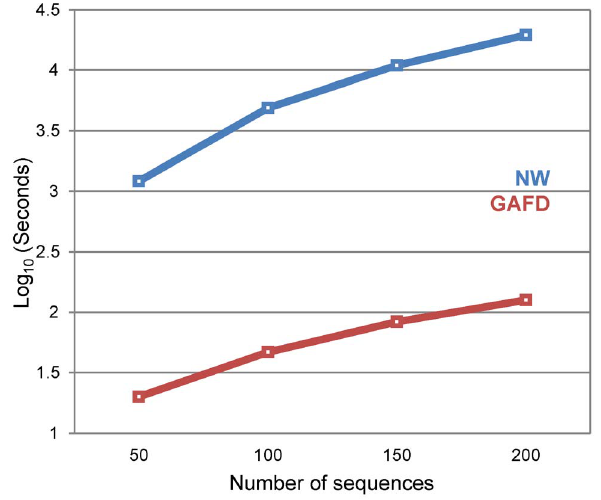
Figure 5. Times required to determine the distance matrix using NW and GAFD. A 10,000 nt random sequence was created. Using this sequence as template, another was created that included 10 random substitutions. The previously created sequence then became a template for the creation of a new sequence with 10 new random substitutions in non-mutated bases. The process was repeated until 20% of the sequence had changed. Then, both NW and GAFD were used to build distance matrices with an increasing number of sequences and the computer time was registered. Results are plotted on a logarithmic